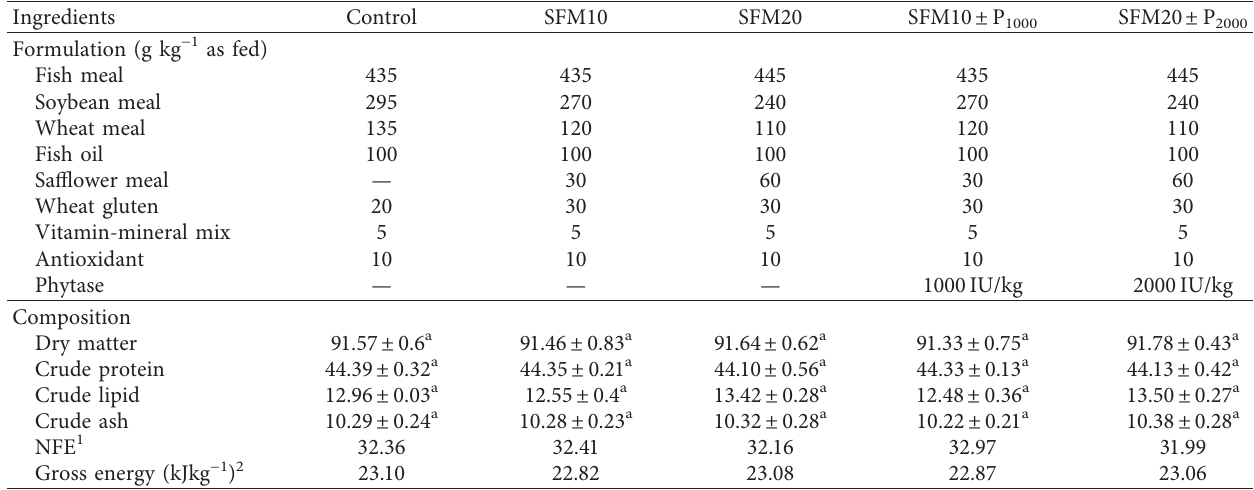
Table 1: Nutritional and chemical proximate composition of experiment